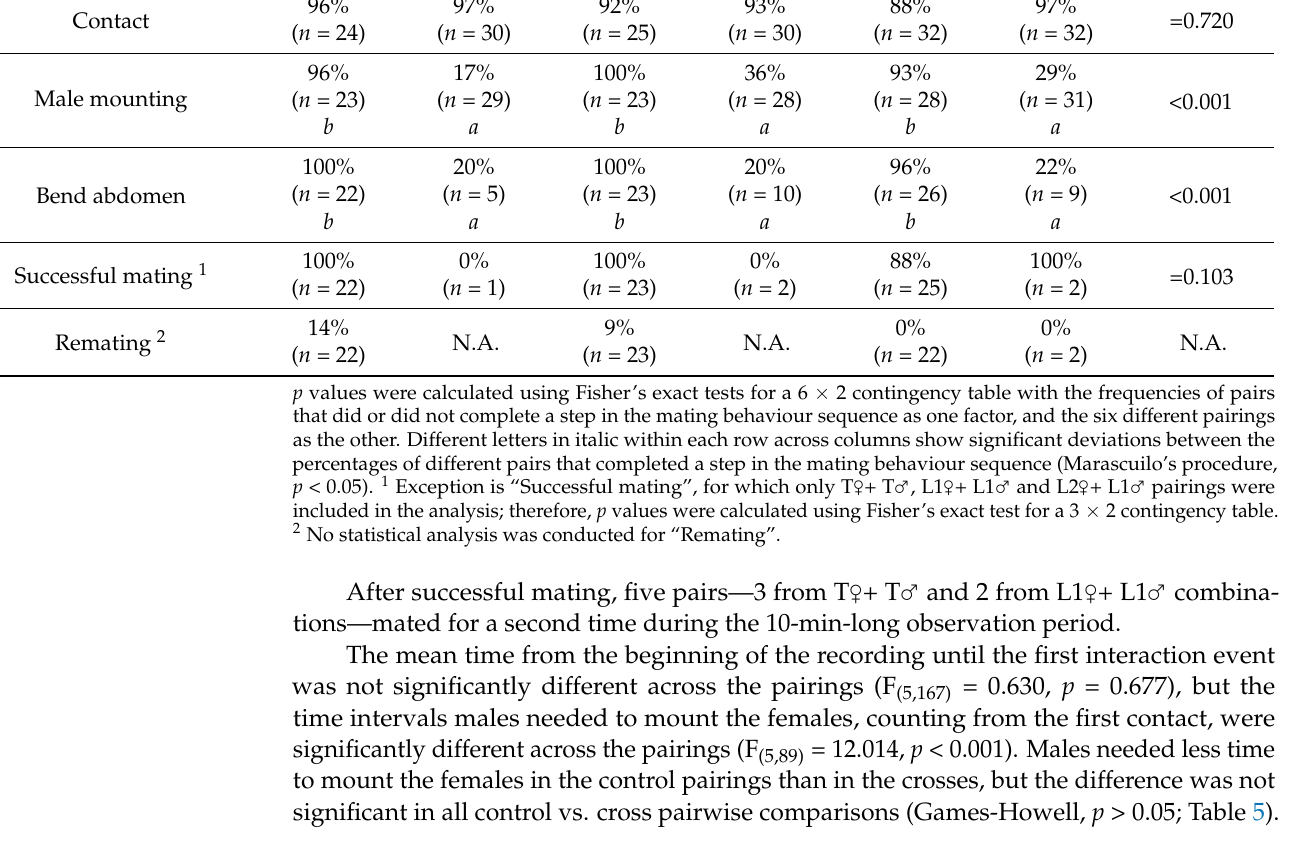
Table 5. The mean time ( ± SD) until the first interaction and the mean time ( ± SD) between the first contact and first male